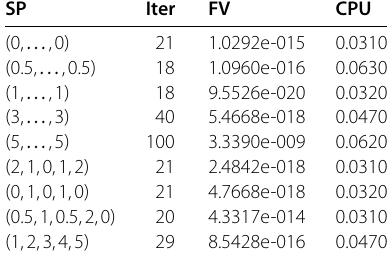
Table 4 Numerical results for Example